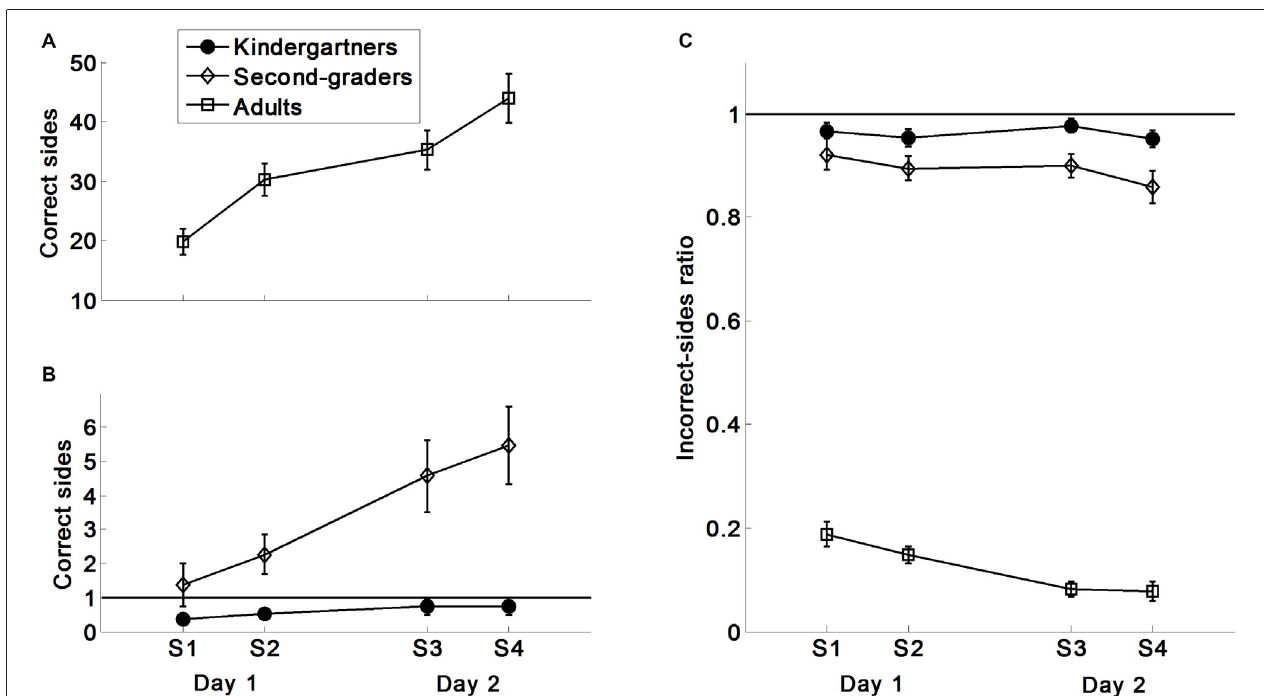
FIGURE 2 | Main outcome measures: the number of correct sides and the ratio of incorrect sides/total sides for children and adults. (A) Correct sides in adults. (B) Correct sides in children. (C) Incorrect-sides ratio.